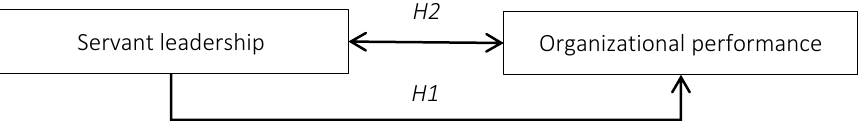
Figure 1. Conceptual